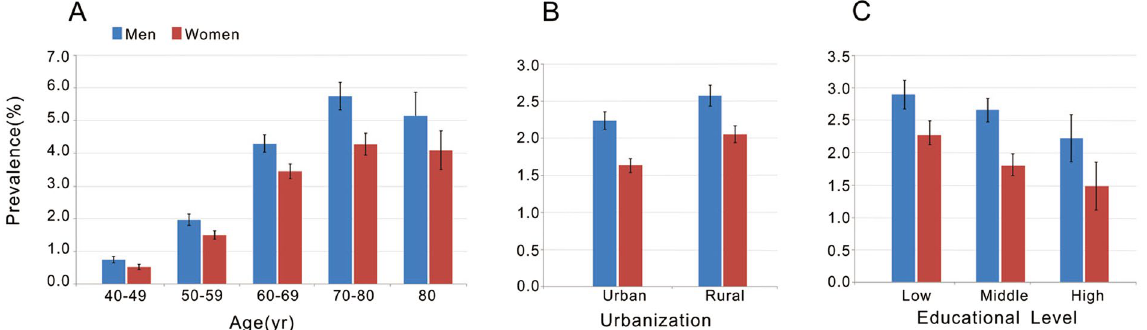
Figure 1. Age-Specific and Age-Standardized Prevalence of Stroke in Chinese Adults aged 40 Years and Older. The prevalence of stroke among men and women is illustrated according to age (Panel A), region of residence (Panel B) and educational level (Panel C). Educational level was classified according to national classification schemes as follows: low educational level indicates primary school education and below; middle educational level indicates secondary school education; high educational level indicates college education and above. Error bars (I) indicate 95% confidence